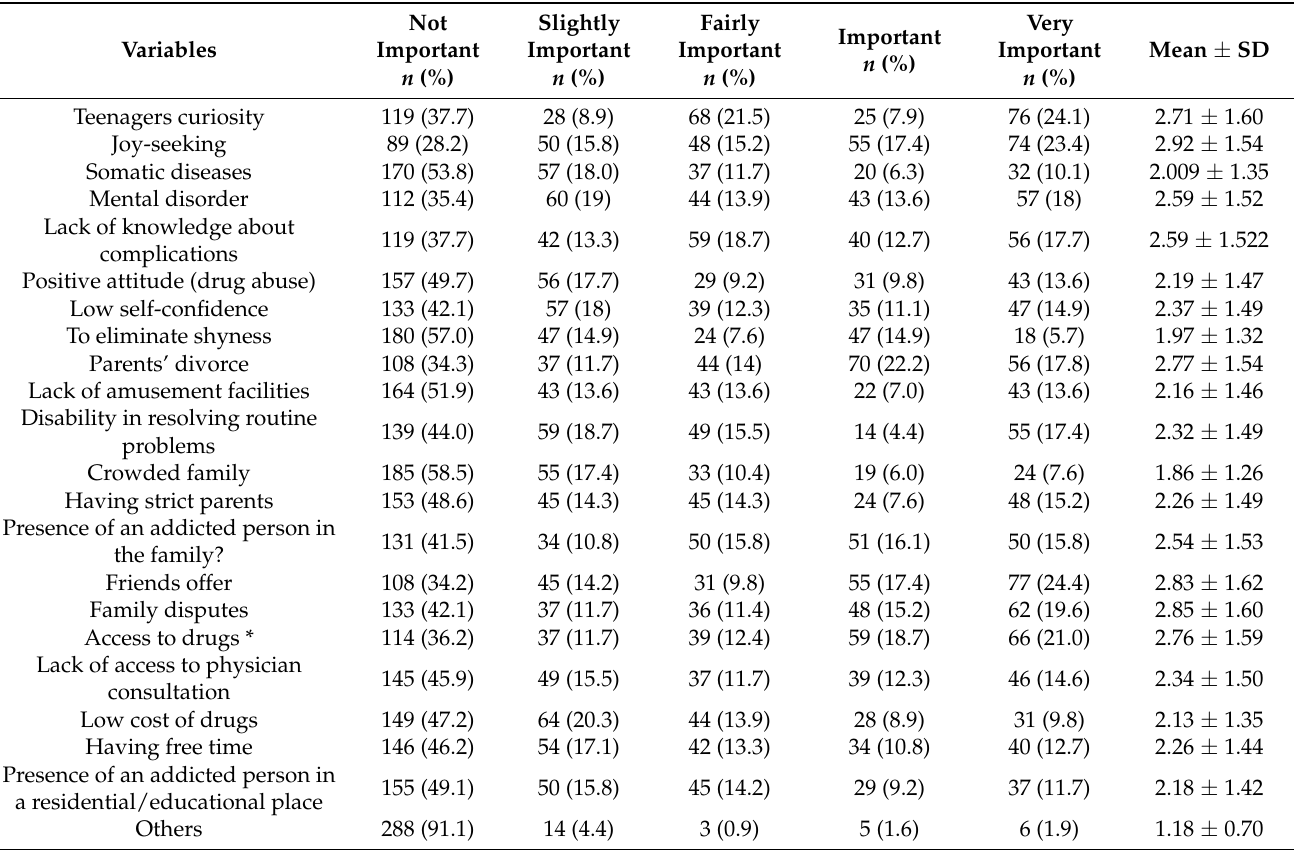
Table 2. Attitudes of students towards factors contributing to the use of illicit drugs and substances among participants.